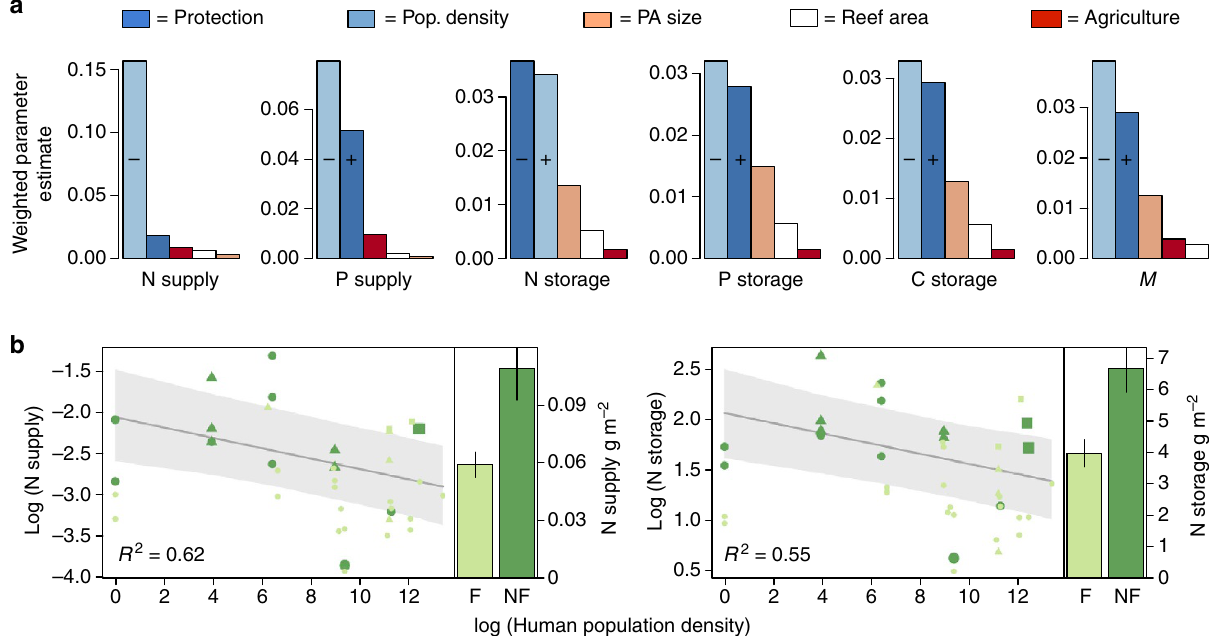
Figure 2 | The relative importance of factors influencing fish nutrient capacity on reefs. ( a ) Bars indicate mean weighted parameter estimates for mixed- effects models (with random intercepts for reef type and country; n ¼ 39) for six ecosystem functions and M (multifunctionality). Predictor variables are arranged by colour and include: protection status–either fished or enforced protection (Protection; dark blue), distance to the nearest population settlement (Pop. Density; light blue), size of marine protected area (PA area; peach), total size of reef tract within 5km radius of the surveyed site (Reef area; white) and area of cultivated land within 50km–a proxy for terrestrial runoff (Agriculture; red). Colours denote the different parameters of interest. ‘ þ ’ or ‘ (cid:2) ’ distinguish the direction of the response for parameters that were within the top model and for which the 95% confidence intervals do not overlap zero. ( b ) Examples of relationships between N supply and storage and the most important continuous predictor–human population density ( n ¼ 39). R 2 values are for the mixed-effects model including only population density as a fixed effect. Grey bands indicate 95% confidence intervals. Symbols indicate different reef type (spur and grove ¼ circle, wall ¼ triangle and slope ¼ diamond) and symbol size indicates relative size of protected area. Colours in all plots indicate protection status (light green ¼ fished, dark green ¼ protected). Barplots show differences between reefs that experience fishing (F) and are protected (NF)–all differences are significant. Error bars indicate s.e. NATURE COMMUNICATIONS|7:12461|DOI: